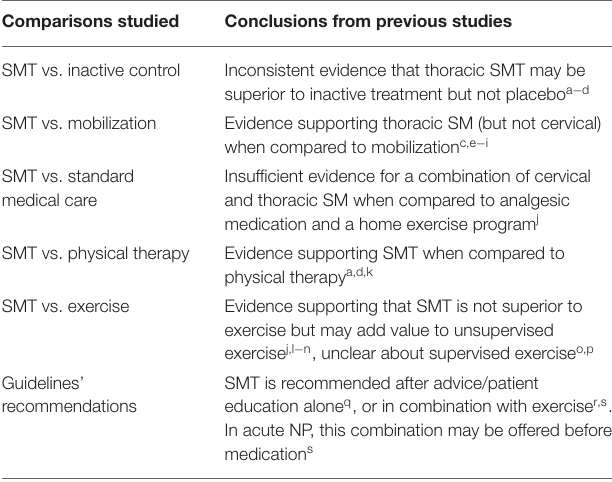
TABLE 1 | Effectiveness and efficacy (compared to inactive controls) of spinal manipulative therapy (SMT) for the management of neck pain (NP). Comparisons studied Conclusions from previous